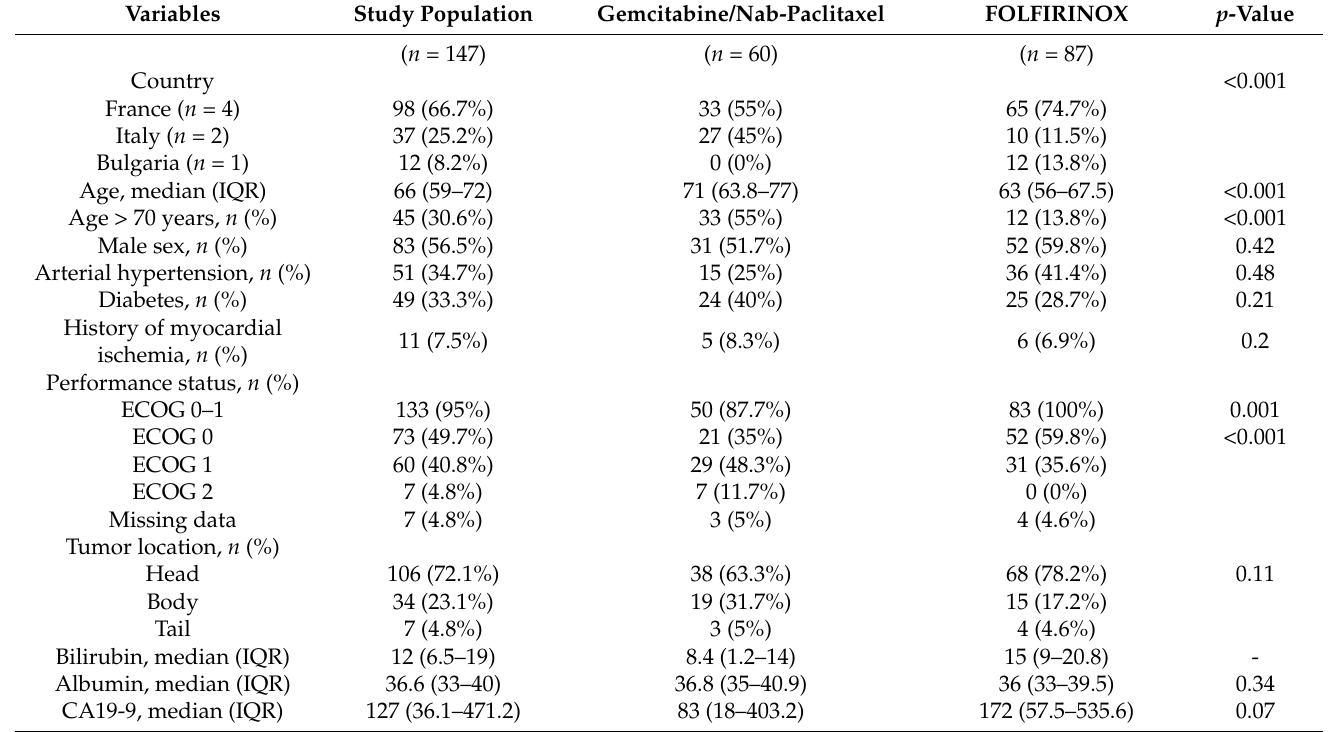
Table 1. Patients’